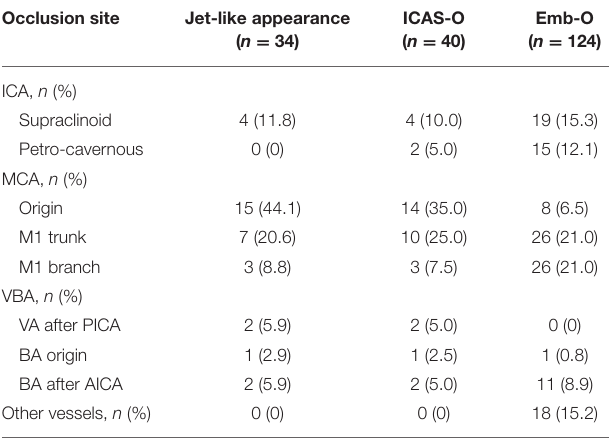
TABLE 2 | Proportion of jet-like appearance and ICAS-O at different occlusion sites.